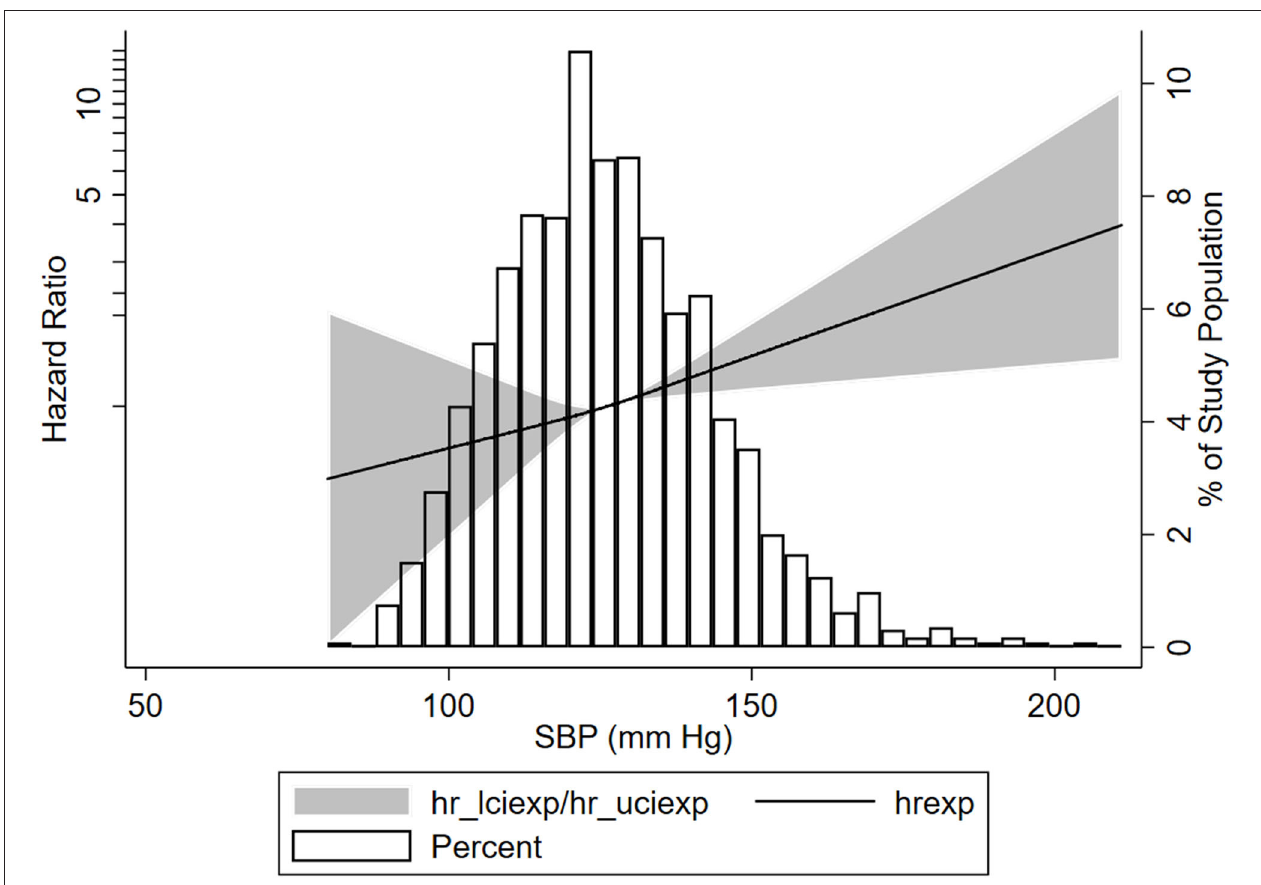
FIGURE 1 | Association of systolic blood pressure (SBP) with the composite kidney failure events in patients with IgA nephropathy. Three knots at the 25th, 50th, and 75th percentiles of SBP levels were used to model the association between SBP levels and composite kidney failure events using restricted cubic splines, Composite kidney failure event was defined as 50% estimated glomerular filtration rate (eGFR) decline or end-stage kidney disease (ESKD). The solid line represents the estimated HR, the shaded area represents the 95% CI, the histogram represents the distribution of SBP levels. The models were adjusted for sex, age, baseline proteinuria, eGFR, antihypertension medications, and Oxford classification.